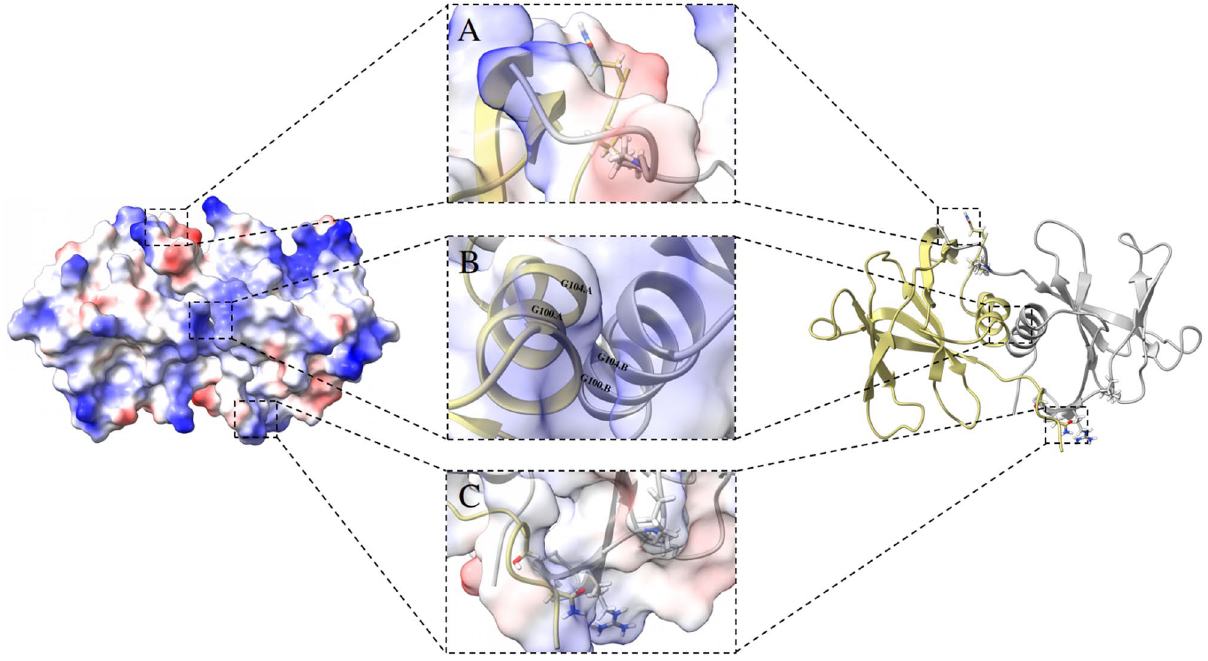
Figure 5. Details of the structure of the dimer with the main regions involved in the contacts between the interfaces. ( A ) and ( C ) represent details of the interactions between the N-terminal region of the monomers. ( B ) shows details of the hydrophobic interactions between the interfaces with residues located near the C-terminal regions of both monomers.